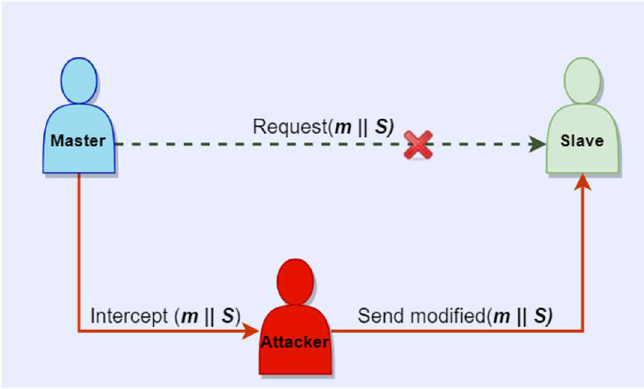
Figure 5. MITM scenario for authentic master-slave communication.